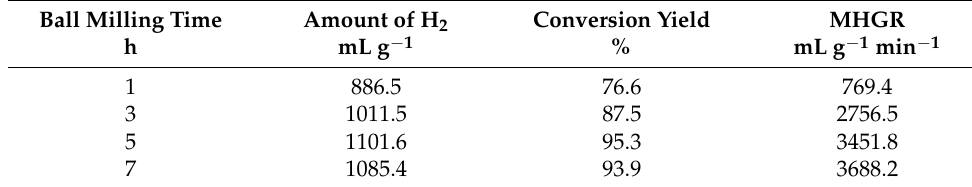
Table 4. Hydrogen generation performances of Al-15 wt% BiOI with different ball milling times at 298.15 K.